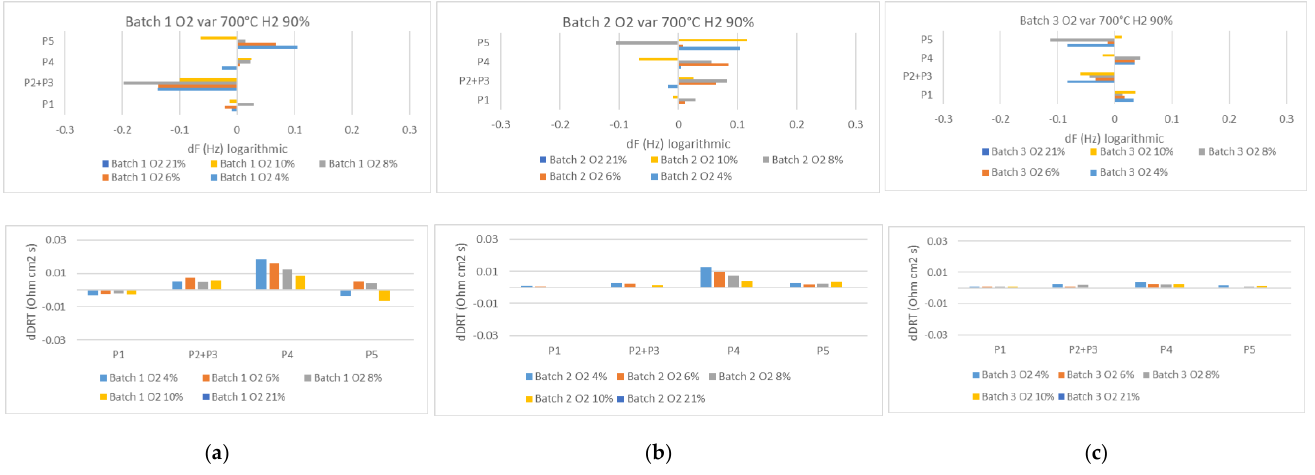
Figure 11. Frequency and DRT change due to oxygen variation at 700 °C and H 2 90%. ( a ) Batch 1. ( b ) Batch 2. ( c ) Batch 3.